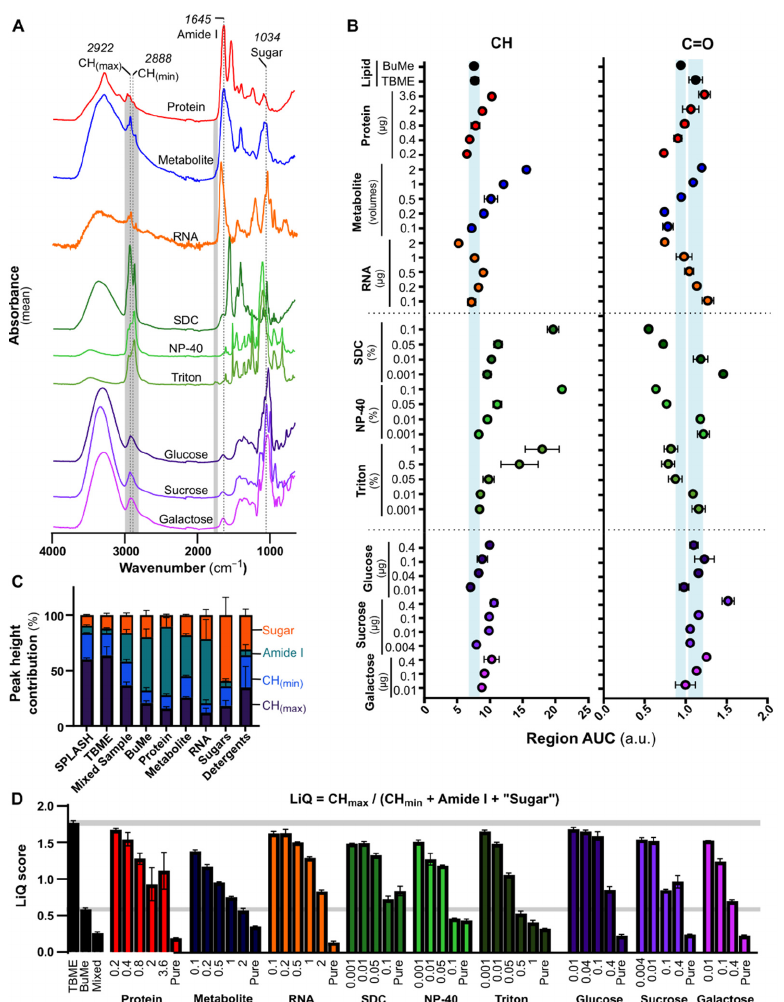
Figure 3. Lipid Quality (LiQ) score development. ( A ) FTIR spectra of common lipid contaminants: protein (1 µg/µL) extracted from cultured cells, RNA (1 µg/µL) from a synthesized primer, metab- olites extracted from cultured cells, the detergents Triton X-100, NP-40, and sodium deoxycholate (SDC, all 1% v / v ), and the sugars sucrose, glucose, and galactose (all 1 µg/µL). Lipid characteristic regions are highlighted in gray, and characteristic contaminant bands are labeled. Three technical measurements were acquired and averaged. ( B ) Quantification of lipid peaks (CH and C=O) by AUC measurements revealed the effects of contaminants on accurate quantitation. Varying concen- trations of contaminant were spiked into pure lipid samples (1 µg per measurement, from TBME extraction). Three technical replicates were acquired for each sample, and error bars represent stan- dard deviation. Light blue regions highlight the expected AUC from TBME- and BuMe-extracted lipids. ( C ) Identification and contribution of prominent peaks in FTIR spectra of biological materials. Prominent spectral regions identified in panel A were evaluated by peak heights and averaged across all replicates. All contaminants considered, including glucose, sucrose, and galactose sugars, and the detergents SDC, Triton-X100, and NP-40, were averaged across the group. The contribution of each peak height is summarized as an averaged percentage and standard deviation. Each contaminant without lipid was also measured (“neat”). ( D ) Contaminated lipid samples evaluated using the LiQ score. Peak heights at CH max were compared to the sum of the CH min , Amide I and sugar peaks. Gray highlighted regions represent the expected LiQ scores for pure lipid or BuMe extracted lipids, within one standard